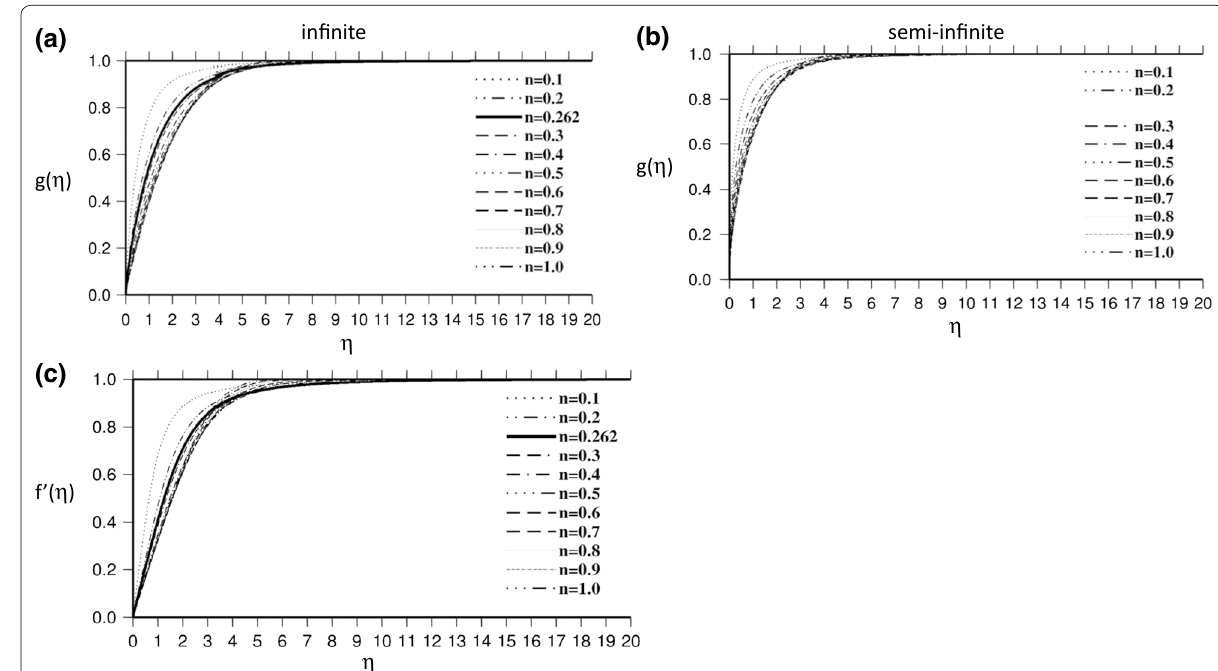
Fig. 5 Non‑dimensional displacement structures obtained for various n ranging from 0.1 to 1.0 using ( a ) the infinite plate model and ( b ) the semi‑infinite plate model. c The non‑dimensional flow rate profiles of Ishak and Bachok (2009) for the infinite model. At approximately n geometrical change of the non‑dimensional flow rate structure graph is in agreement with the reduction in n . The graph is shifted down and right as n decreases in the n > 0.6 domain, whereas it is shifted up and left as n decreases in the n < 0.6